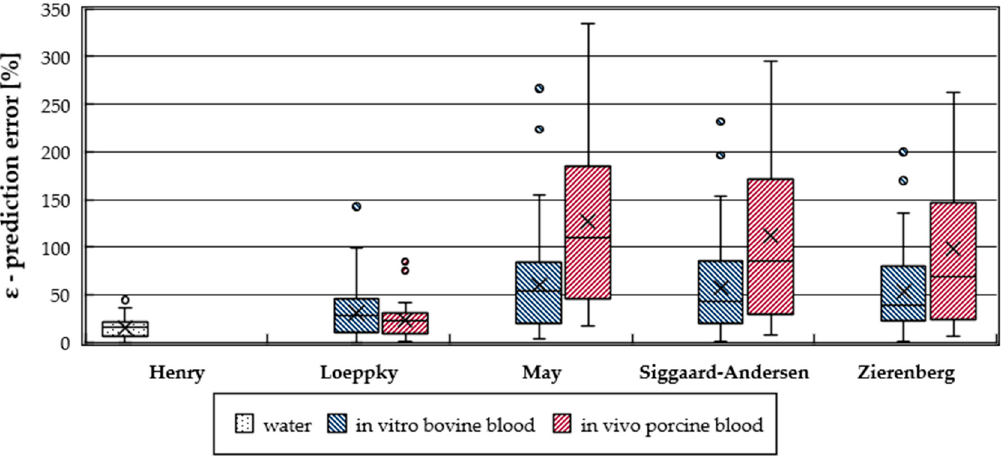
Figure 7. Prediction error distribution of all measurements compared for the different CO 2 solubility models and experi- mental trials–in vitro bovine and in vivo porcine.